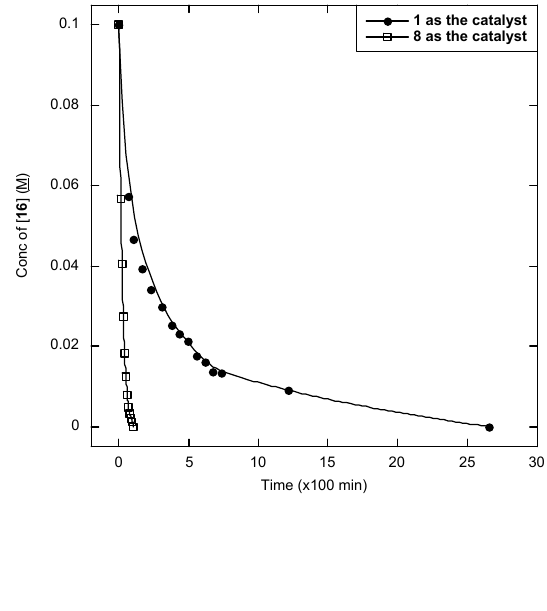
Figure 2. Oxidation of 16 (10 μ L, 71 μ mol) by 1 (4.1 mg, 8.7 μ mol, 12 mol%) and 8 (4.6 mg, 8.7 μ mol, 12 mol%) in acetone -d (0.7 mL) in the presence of potassium 6 tert -butoxide (1.6 mg, 14 μ mol, 20 mol%) at 100 °C in a sealed J-Young tube. Points are plotted for the concentration of 16 vs . time, where circles and squares respectively represent reactions catalyzed by 8 and 1